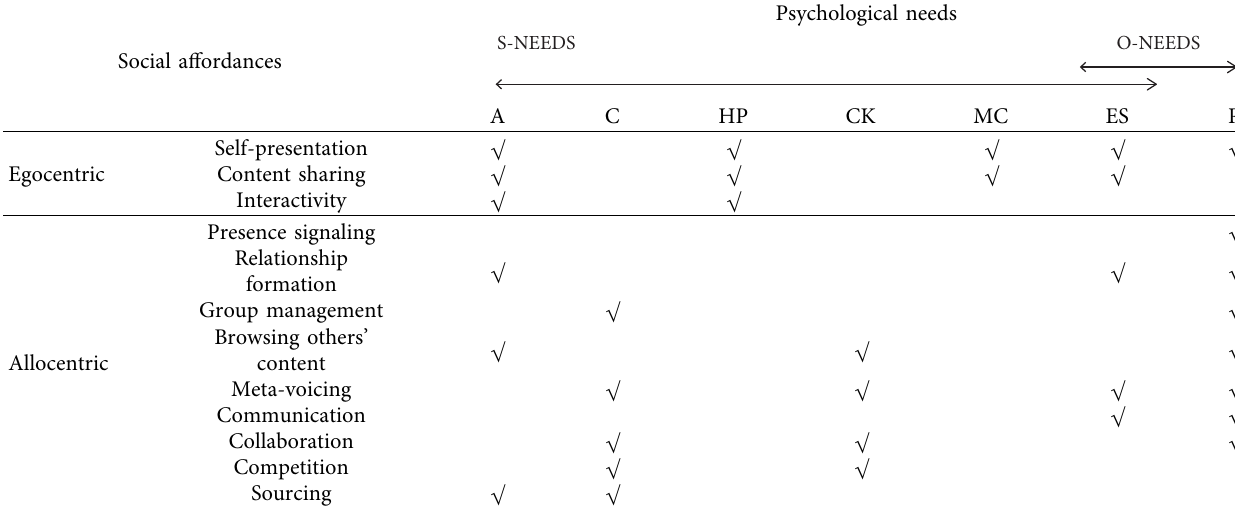
Table 3: Research on the relationship between psychological needs and social affordances.